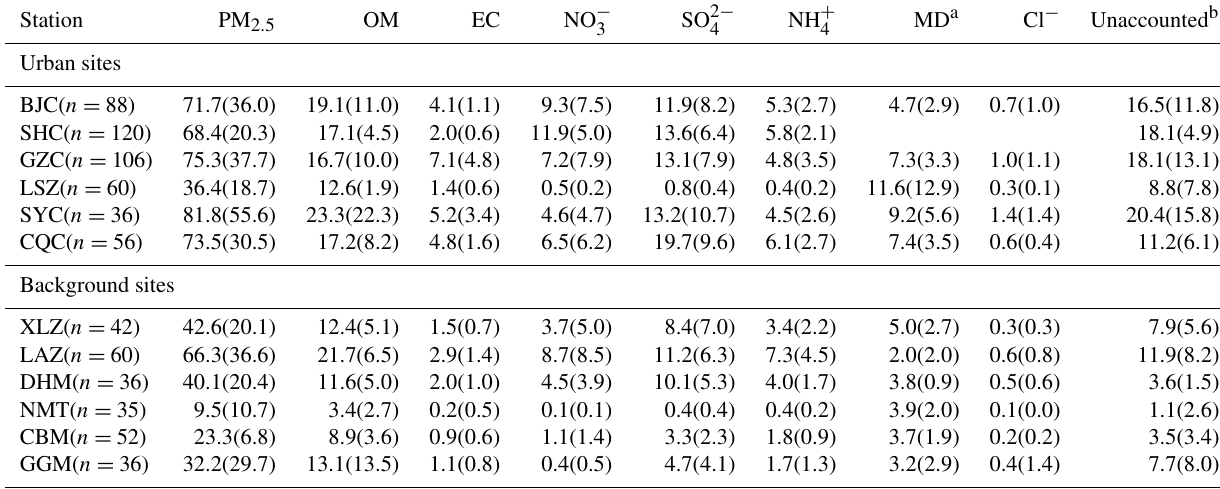
Table 2. Summary of the concentrations of PM 2 . 5 and its components (µgm − 3 ) at urban and background sites.